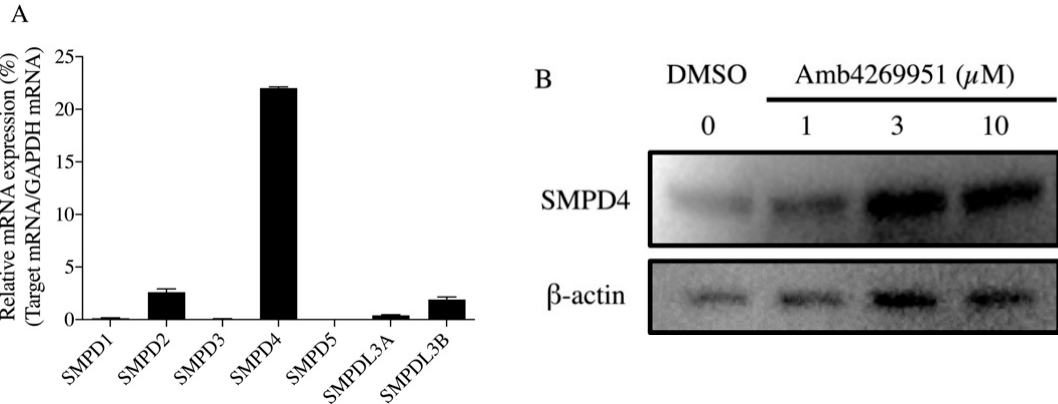
Figure 4. E ff ect of Amb4269951 on the expression of sphingomyelinases in U251MG cells. ( A ) Real-time PCR analysis of the mRNA expression of SMPD1-5, SMPDL3A, and SMPDL3B in U251MG cells. The percentage of relative mRNA expression is expressed as the ratio of the target mRNA to the glyceraldehyde-3-phosphate dehydrogenase (GAPDH) mRNA. Each column represents the mean ± SD ( n = 3). ( B ) E ff ect of Amb4269951 on the expression of SMPD4 protein in U251MG cells. Cells were incubated with various concentrations of Amb4269951 for 4 h. Western blot analysis shows the SMPD4 and ß-actin levels in whole cell lysates of drug-treated U251MG cells.